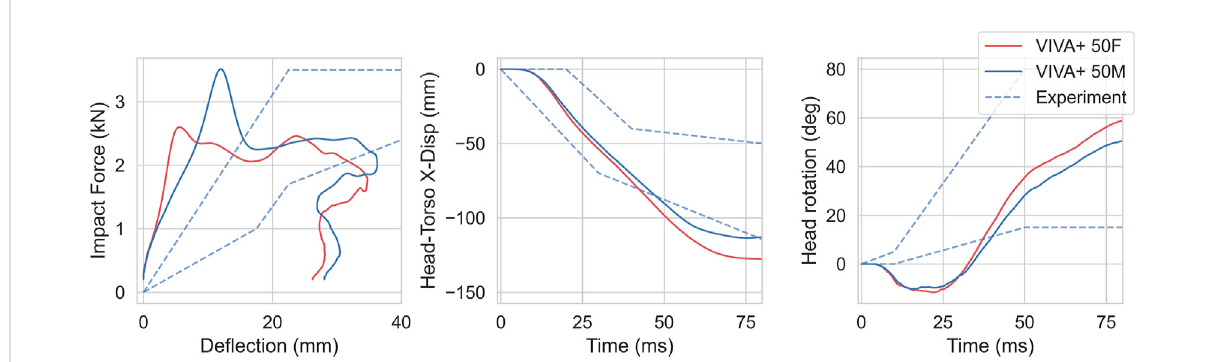
FIGURE 10 Kinetics and Kinematics for 4.4 m/s blunt impacts at T1, compared with responses from Viano et al., 2001. (left) Impact force-chest de fl ection response. (center) Head retraction represented by Head x-displacement with respect to T1. (right) Head rotation with respect to